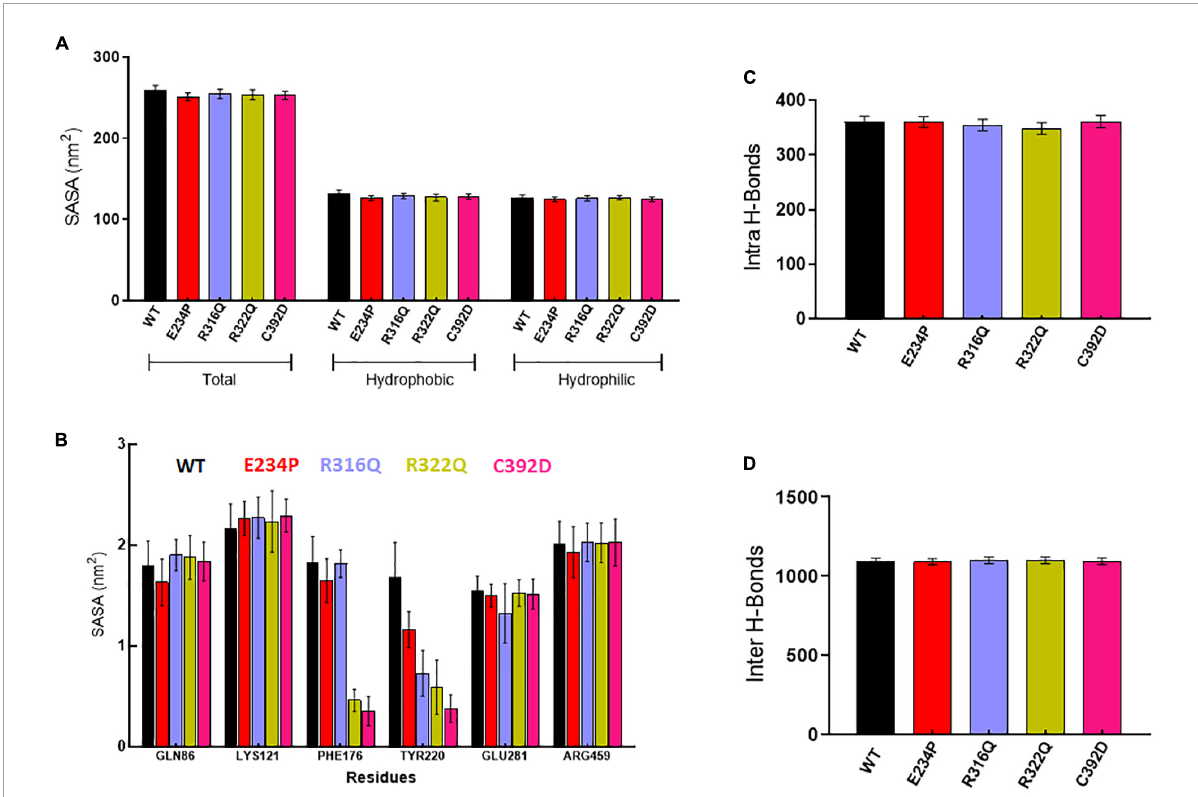
FIGURE3 Structural properties analyses of WT and MT proteins. (A) Total, hydrophobic and hydrophilic solvent accessible surface area plot, (B) solvent accessible surface area of protein residues, (C) total number of intra or protein-protein hydrogen bond and (D) total number of inter or protein-water hydrogen bond. WT, E234P, R316Q, R322Q, and C392D were labeled in black, red, blue, mustard, and magenta color, respectively.